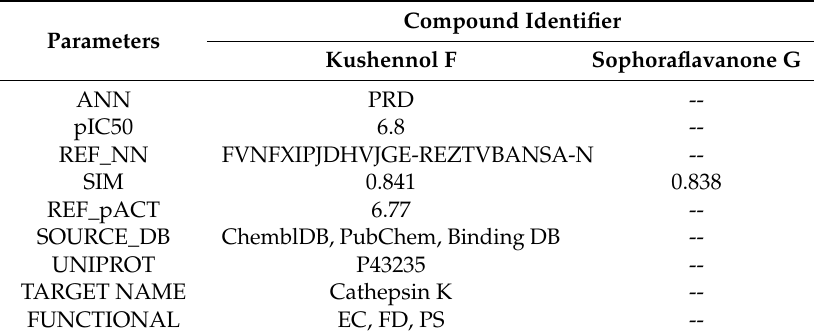
Table 1. The information of Kushennol F (KF) and Sophoraflavone G (SG) linked to Ctsk retrieved from